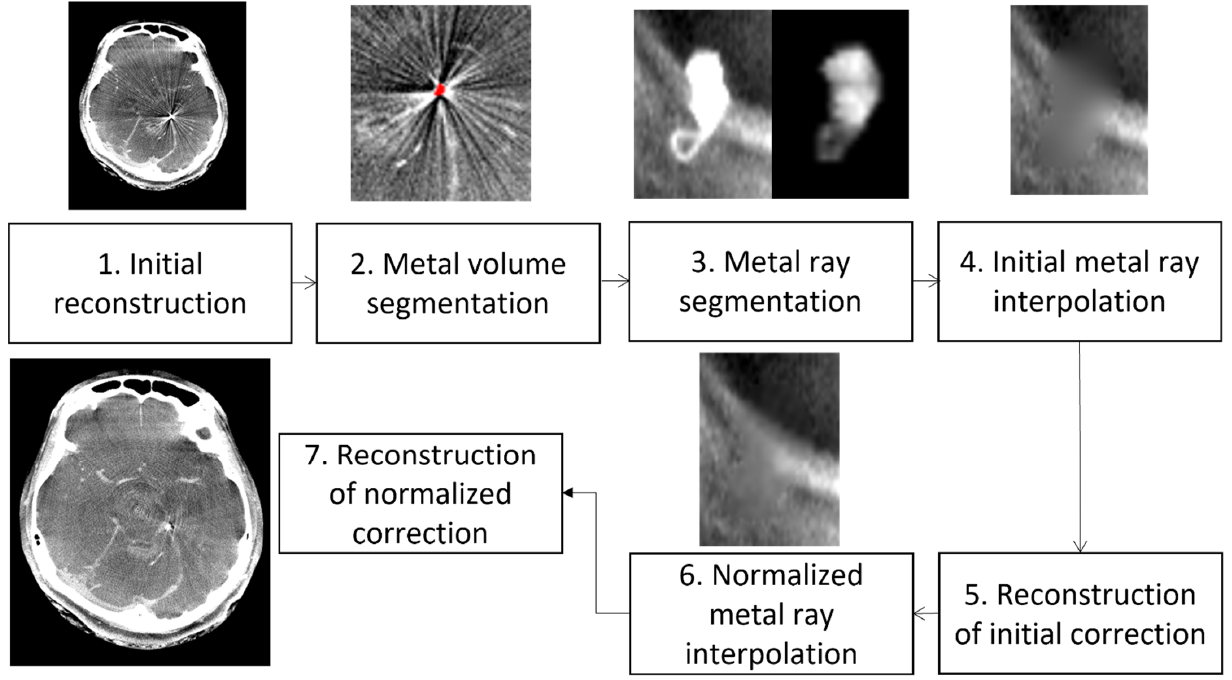
Figure 1. Flowchart of the iMAR technique. The interpolation-based iMAR technique is described in detail by Meyer et al. [21,22].